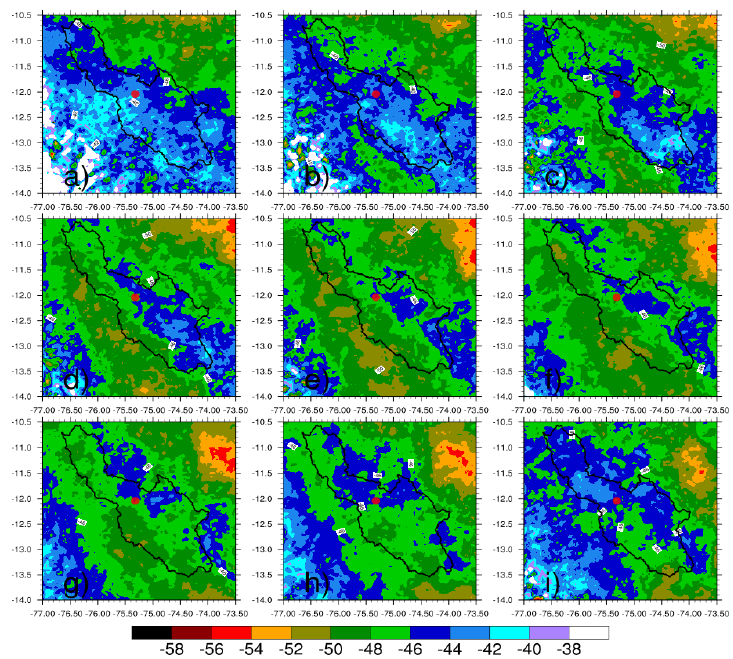
Figure 13. Average spatial of brightness temperature (°C), ( a ) 11 LST, ( b ) 12 LST, ( c ) 13 LST, ( d ) 14 LST,